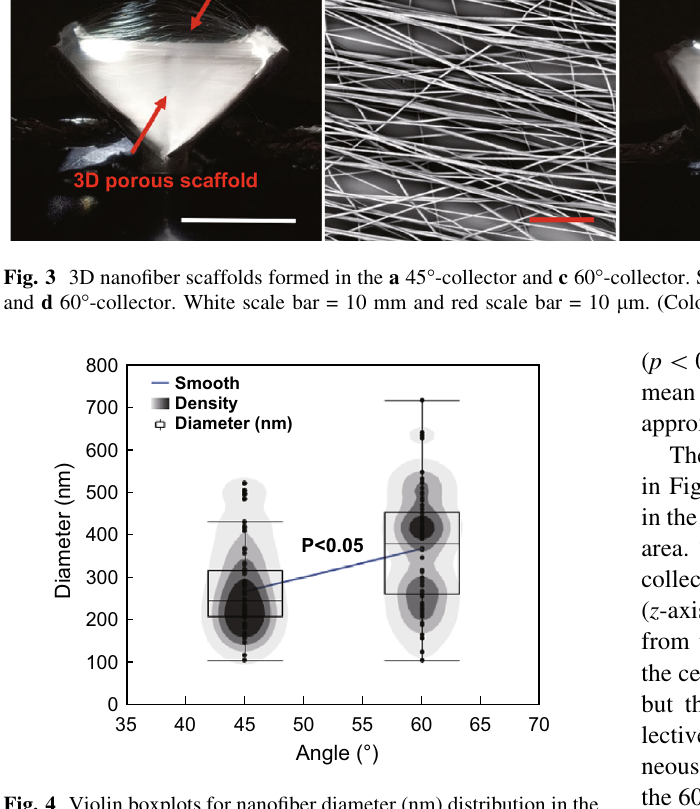
Fig. 4 Violin boxplots for nanofiber diameter (nm) distribution in the two